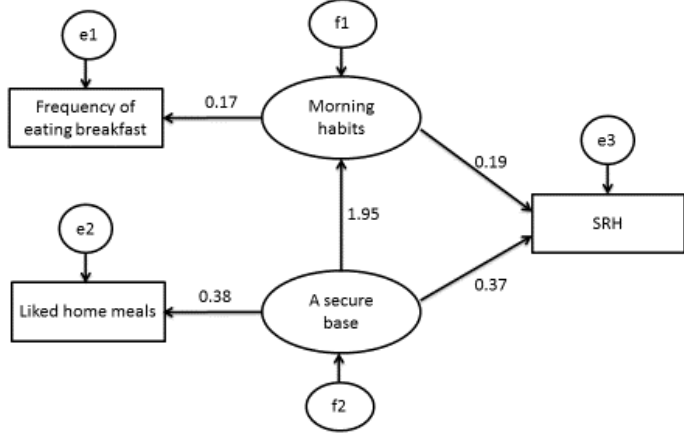
Figure 1. The structural equation model related to SRH and food habits ( n = 1296). Note: Rectangles indicate observed variables and ovals indicate latent variables. Values of single arrowheads indicate standardised coefficients. All pathways are significant ( p < 0.05). Self-rated health was associated with morning habits and a secure base.